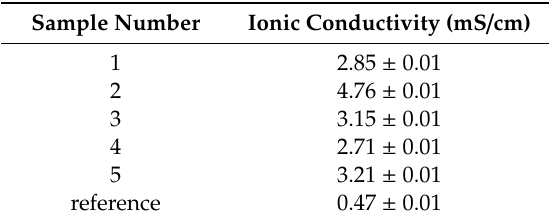
Table 2. Ionic conductivities of the gel electrolyte solutions and the liquid Man Solar electrolyte of the reference measured at 40 °C.